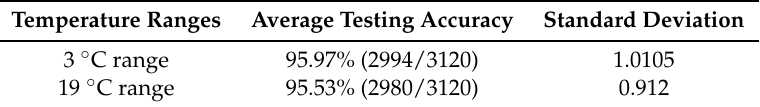
Figure 17. Confusion matrix results with a temperature range of 39 ◦ C–42 ◦ C. Table 5. Diagnosis results for different temperature